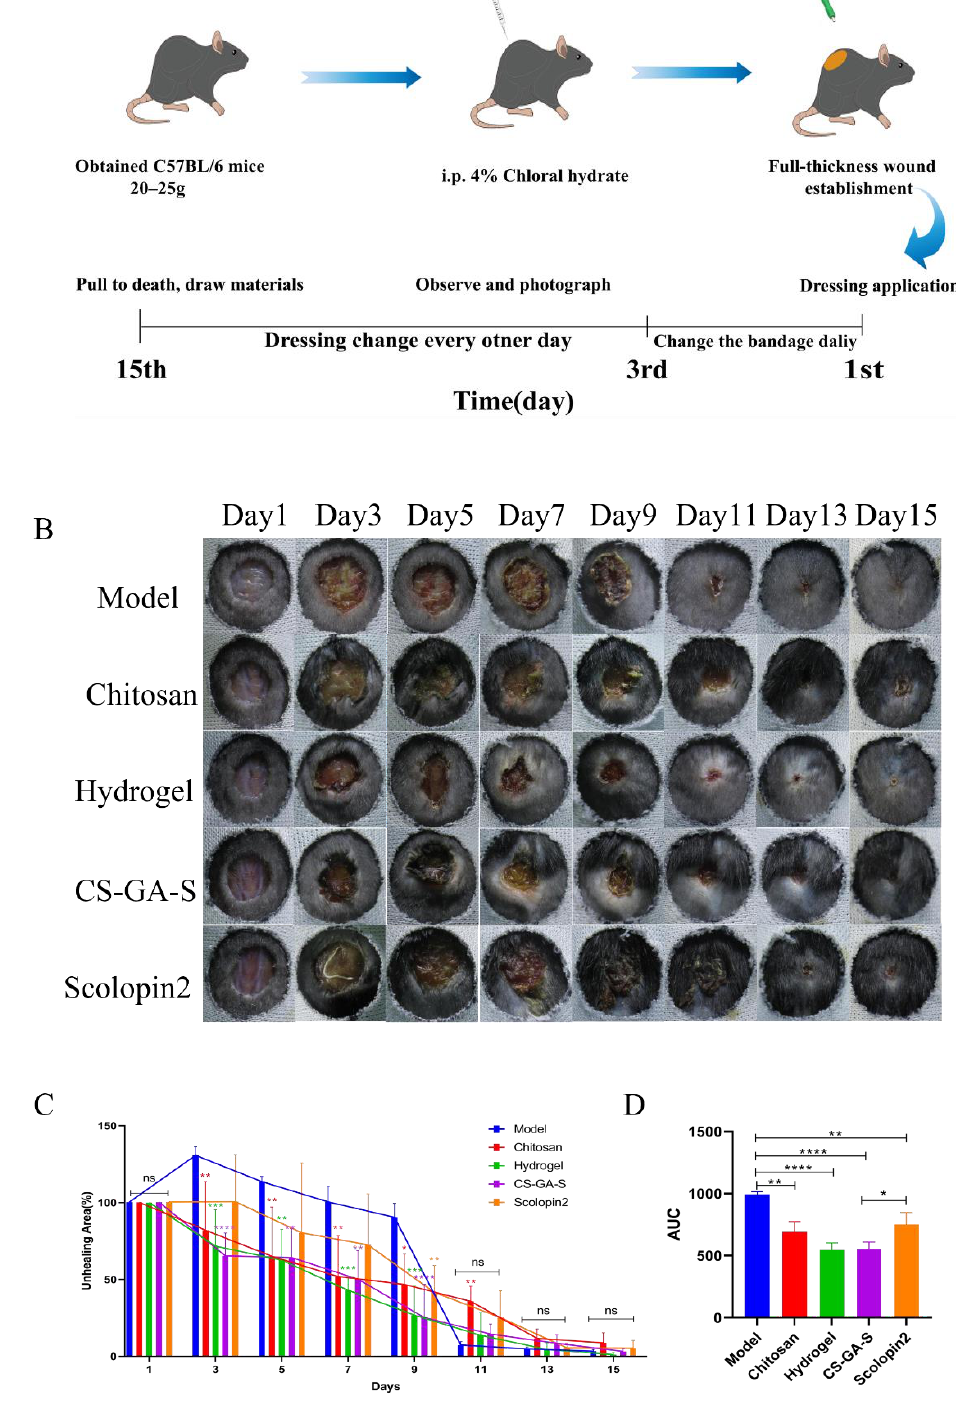
Figure 9. In vivo wound healing evaluation with wound mice. ( A ) Model building and drug administration process. ( B ) The wound area representative photos of the mice of all the five groups in the time of treatment. ( C ) The bar chart and line chart of the wound area. ( D ) The quantified area under the curve (AUC). ns represents no significance, * represents p < 0.05, ** represents p < 0.005, ***represents p < 0.0005, ****represents p < 0.0001.